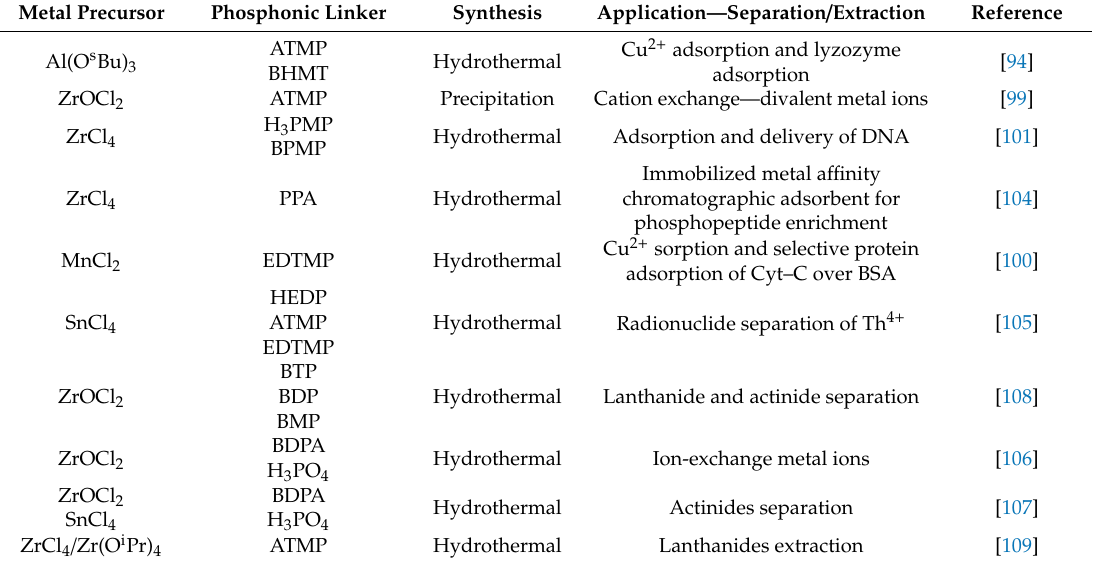
Table 1. Separation and extraction application list for porous metal